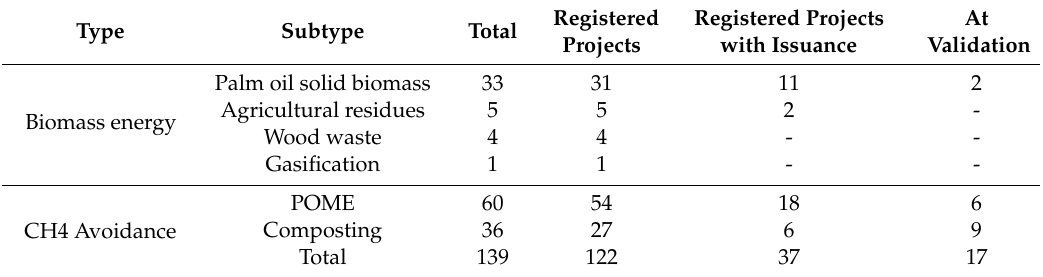
Table 1. 2015. Project undertakings (clean development mechanism (CDM)) and their distribution in palm oil producers by project type